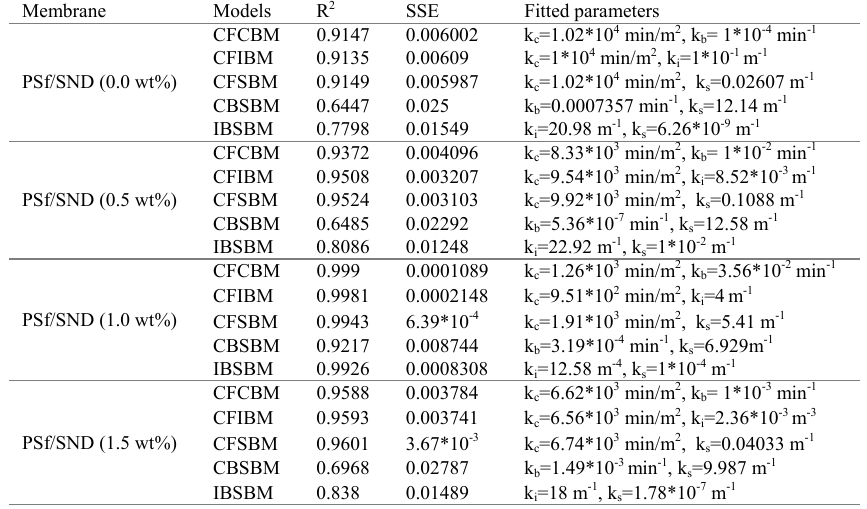
Table 5. Model parameters, regression coefficient and error of fit for constant pressure combined models of membrane fouling.